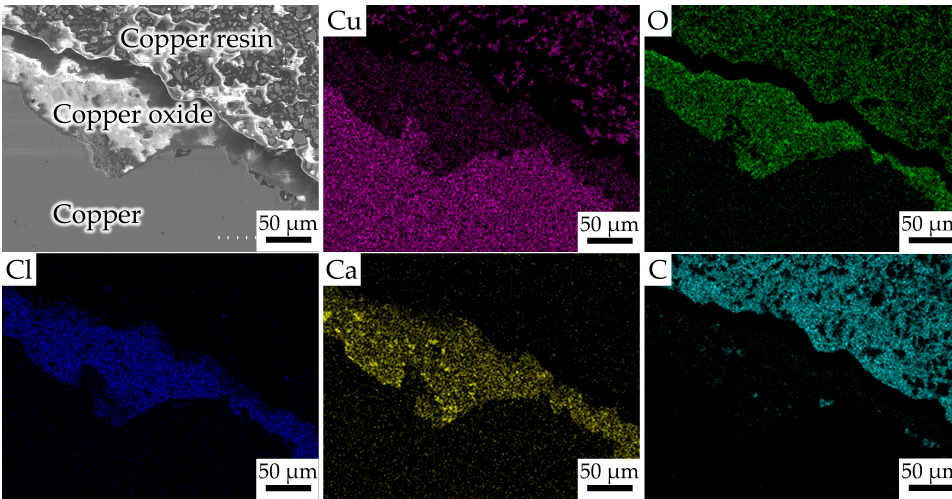
Figure 4. Elemental mapping on the longitudinal section of the molten mark in case FS1-1.